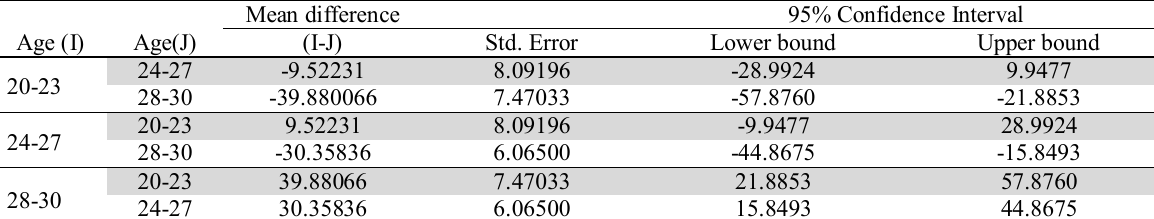
The summary of Dunnett test Mean difference